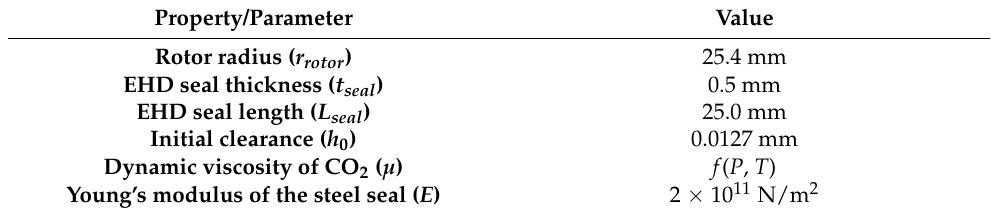
Table 1. Geometric and material